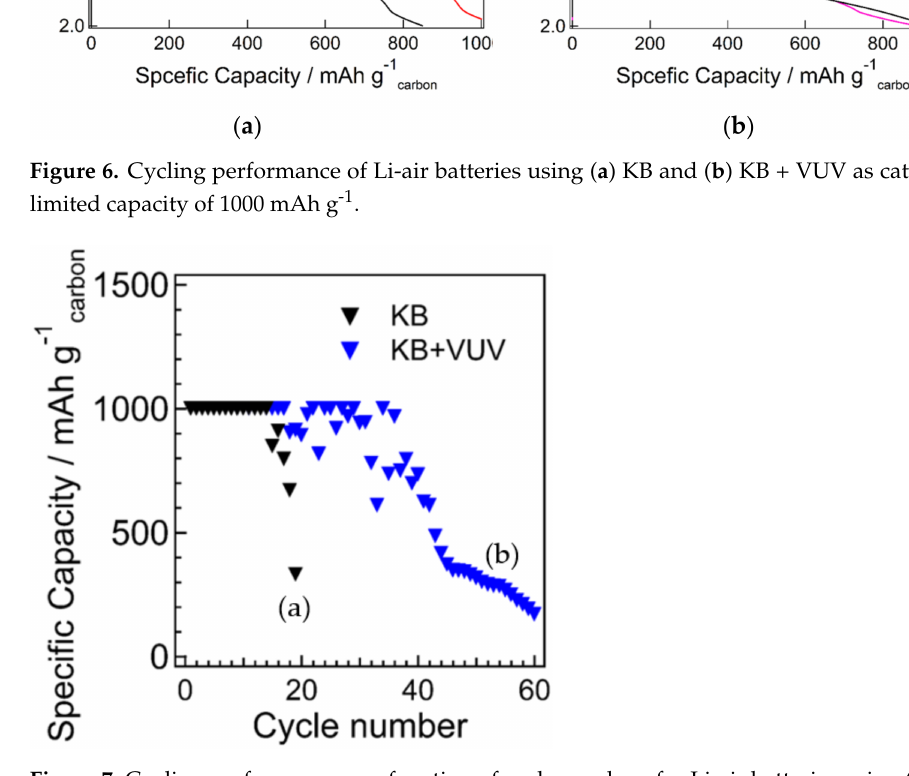
Figure 7. Cycling performance as a function of cycle numbers for Li-air batteries using (a) KB and (b) KB + VUV as cathodes at a limited capacity of 1000 mAh g − 1